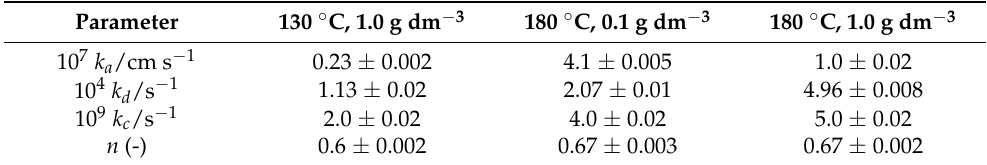
Table 3. Best-fit values of kinetic parameters of deposition, detachment and consolidation of mag- netite on AISI 316L in the AMETA coolant at 130 and 180 ◦